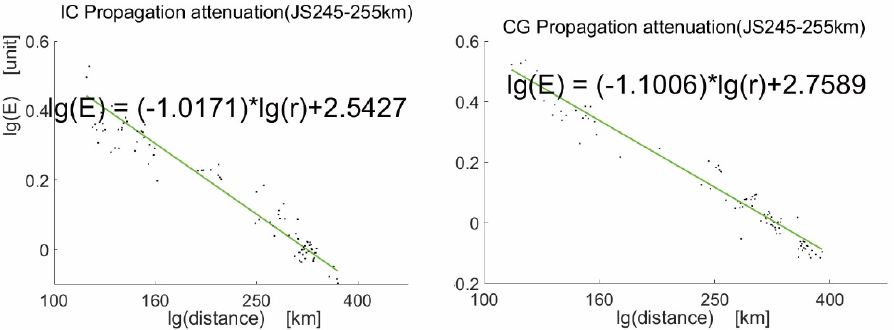
Figure 11. Observation results of EM pulse peak value at the HF station for lightning events located 250 km from the JS station.